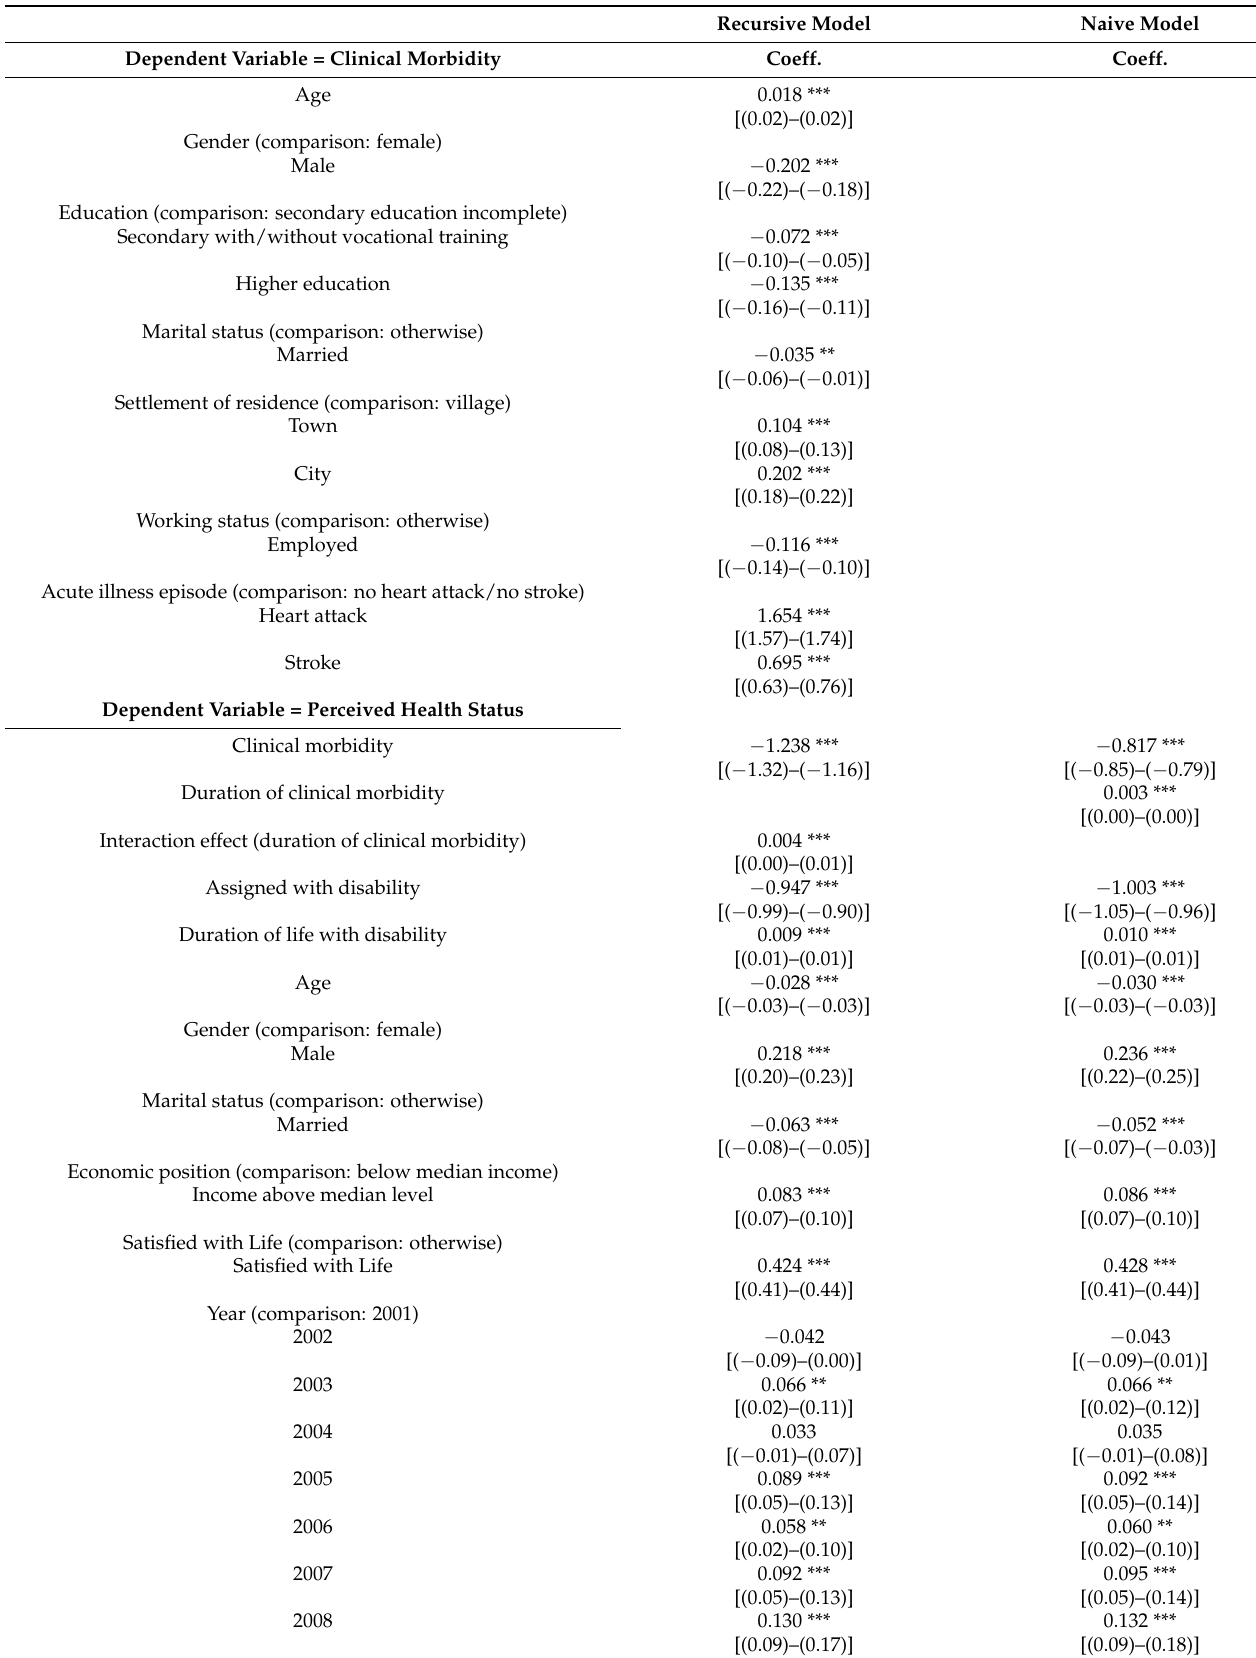
Table 3. The model